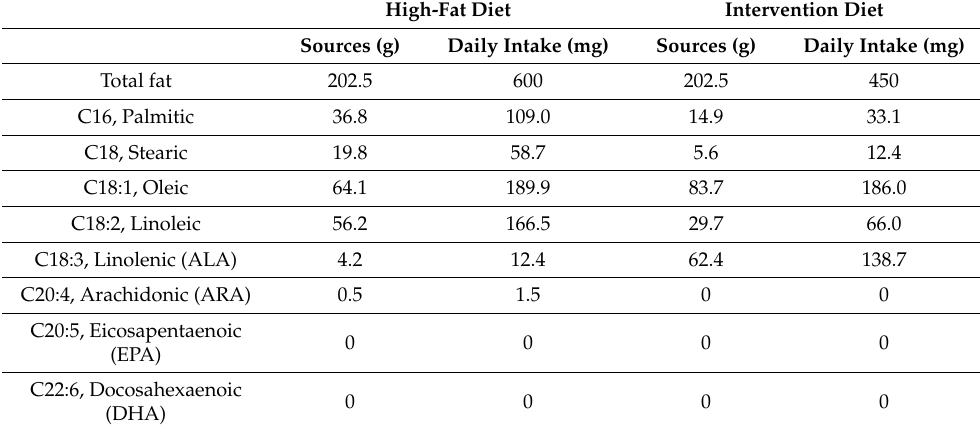
Table 2. Fatty acids composition of HFD and INT diet and the daily fatty acids intake of the different experimental groups. Distribution of saturated and unsaturated fatty acids in HFD and INT diets. Daily intake of HFD and INT mice in saturated fatty acid (SFA) and unsaturated fatty acids (UFA). High-Fat Diet Intervention Diet Sources (g) Daily Intake (mg) Sources (g) Daily Intake (mg) Total fat 202.5 600